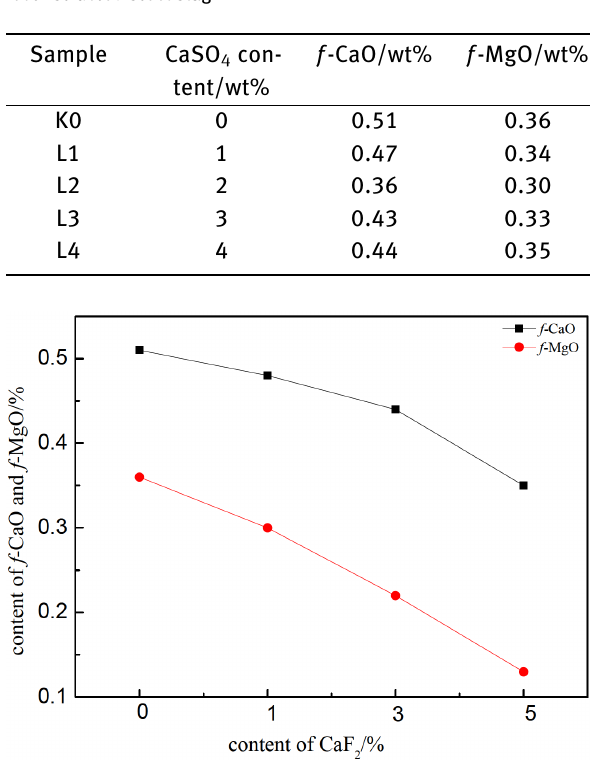
Table 5: Effect of CaSO 4 on the f -CaO and f -MgO contents in the